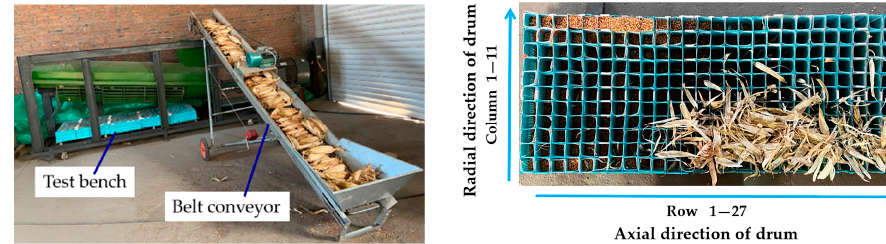
Figure 2. Test bench of longitudinal axial threshing drum.